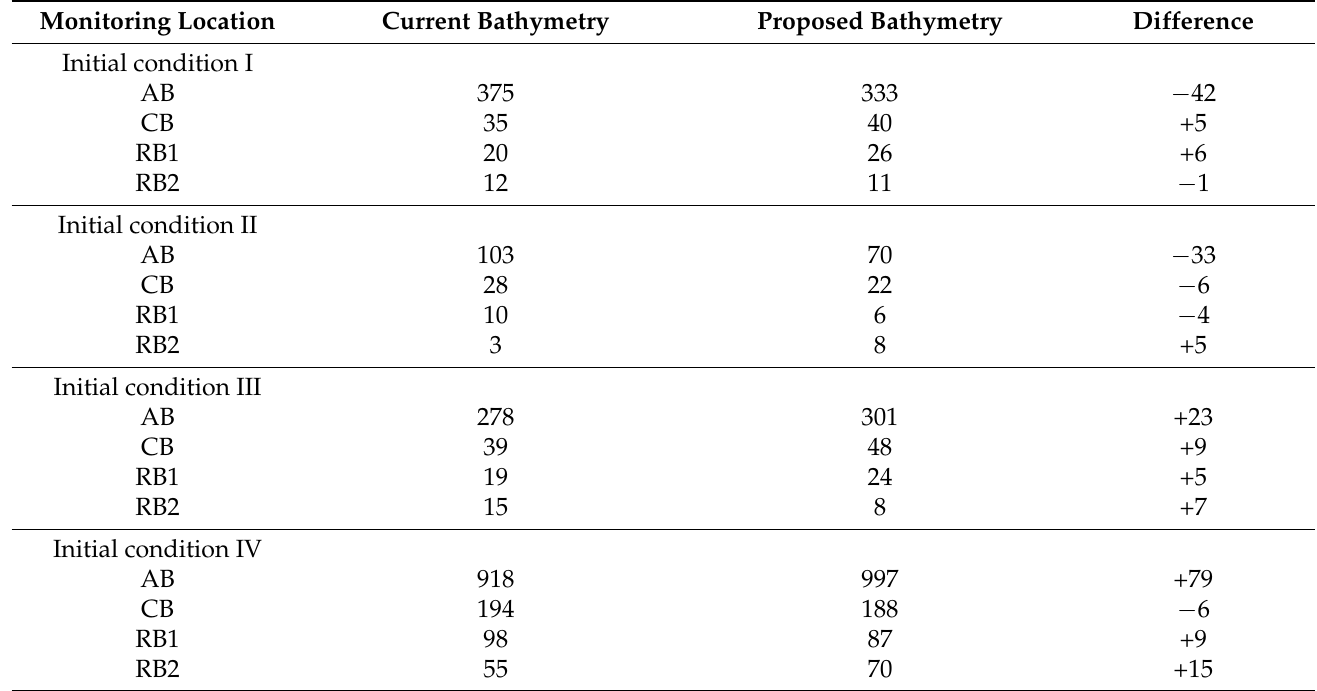
Table 3. Larvae counting location data for 2012